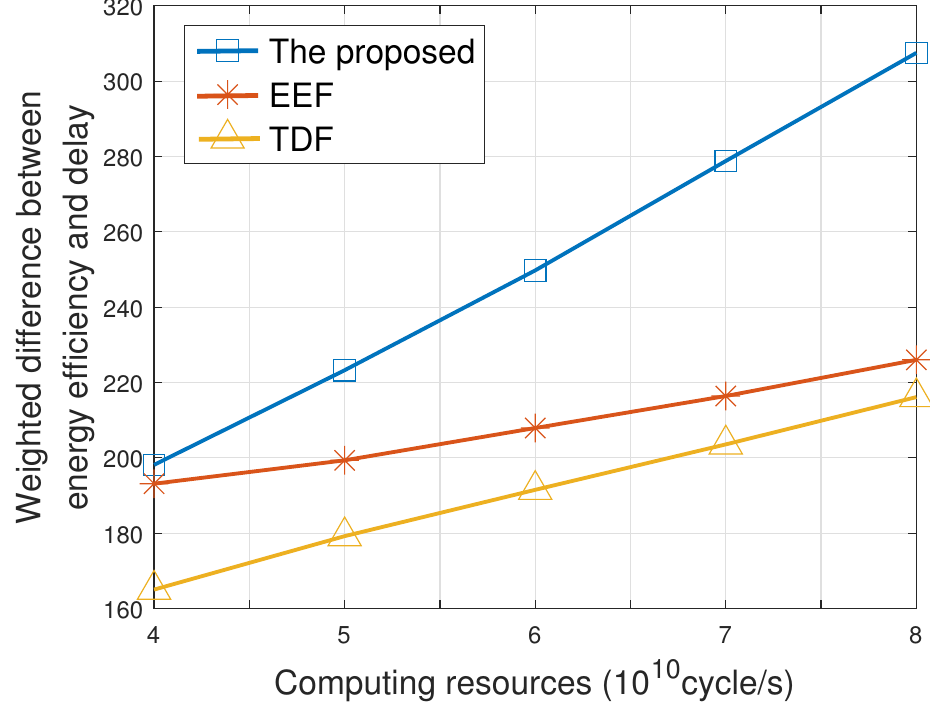
Figure 8. Weighted difference between energy efficiency and delay versus computing